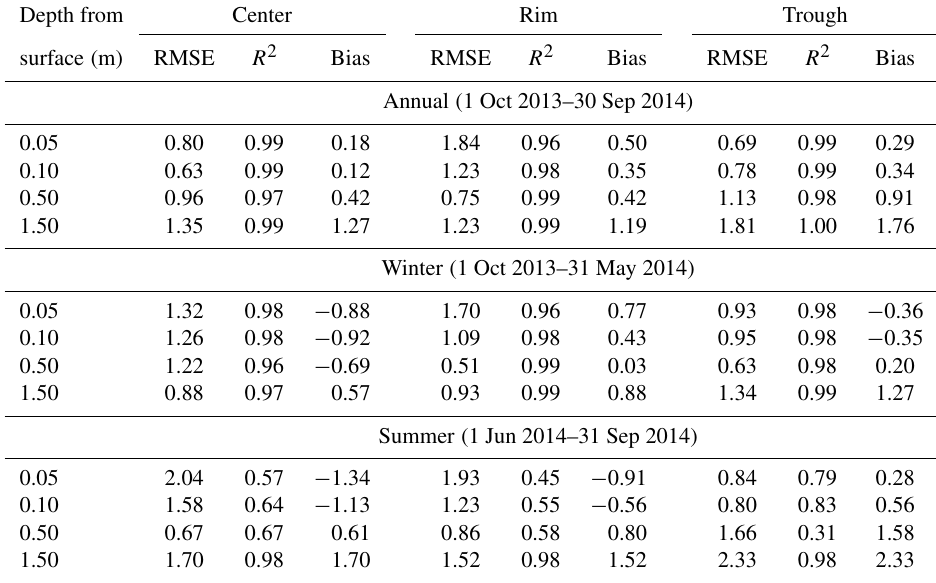
Table 5. Model performance statistics at Site C compared to observed soil temperatures (for annual, winter and summer periods). The model shows higher bias during the summer season compared to winter. Depth from Center Rim Trough surface ( m )